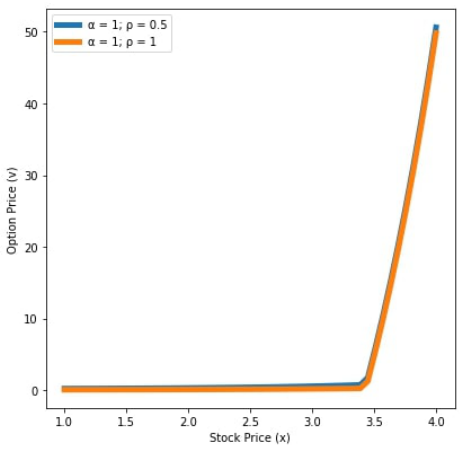
Figure 5. Values of the options for α = 1 and ρ < 1, t = 0.5 years with y =